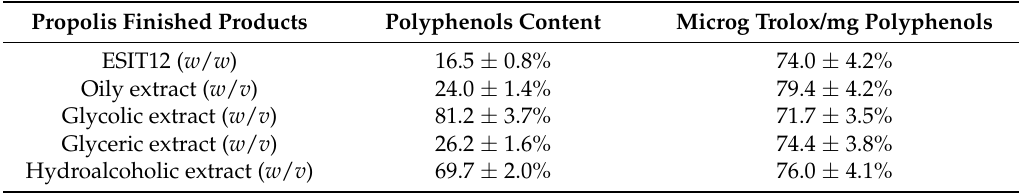
Table 2. Polyphenols content and antioxidant activity of the various propolis preparations measured by the radical scavenging effect on 2,2-diphenyl-1-picrylhydrazyl (DPPH) and reported as µ g trolox (6-hydroxy-2,5,7,8-tetramethylchroman-2-carboxylic acid) equivalent/mg polyphenols. Data are illustrated as mean ± standard